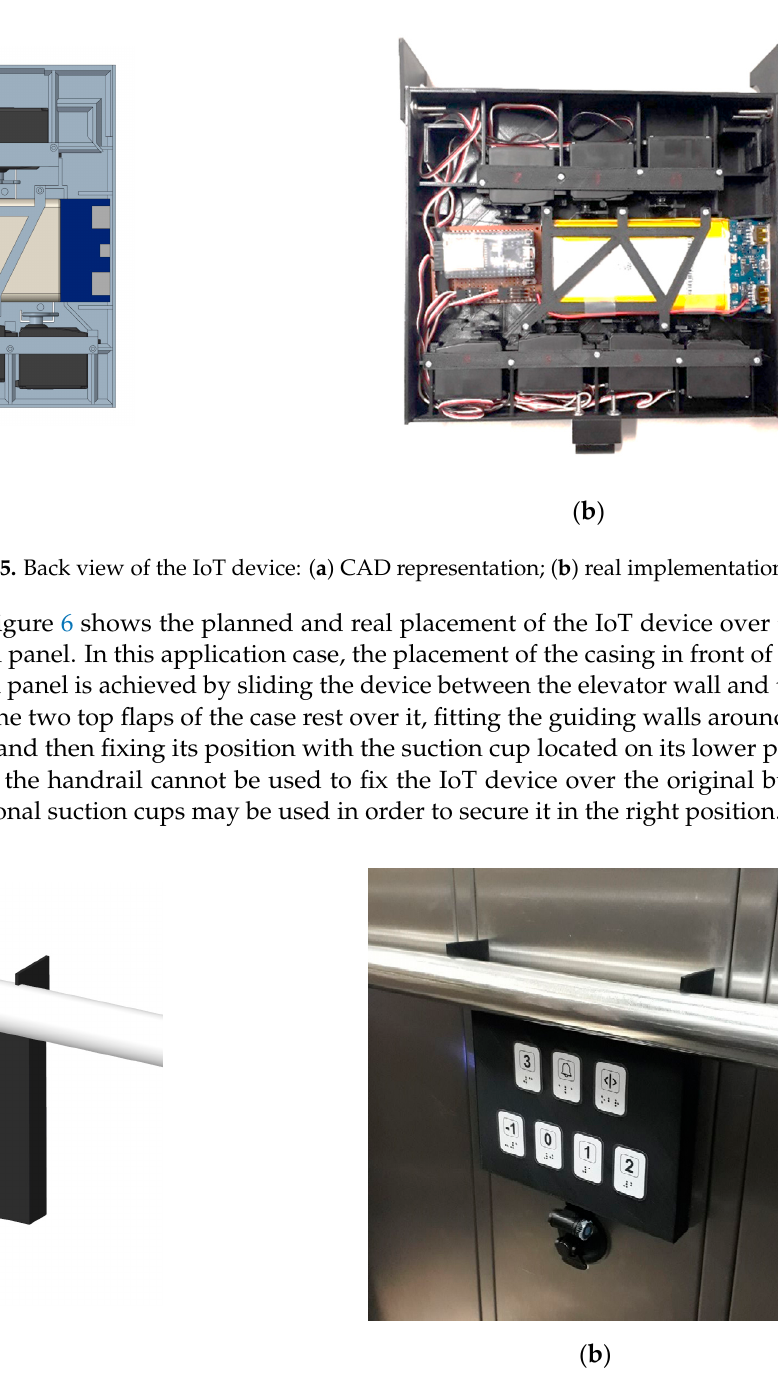
Figure 6. Application of the IoT device as an add ‐ on module: ( a ) CAD representation; ( b ) real implementation with labels over the cantilever ‐ like buttons that replicate the original control panel.